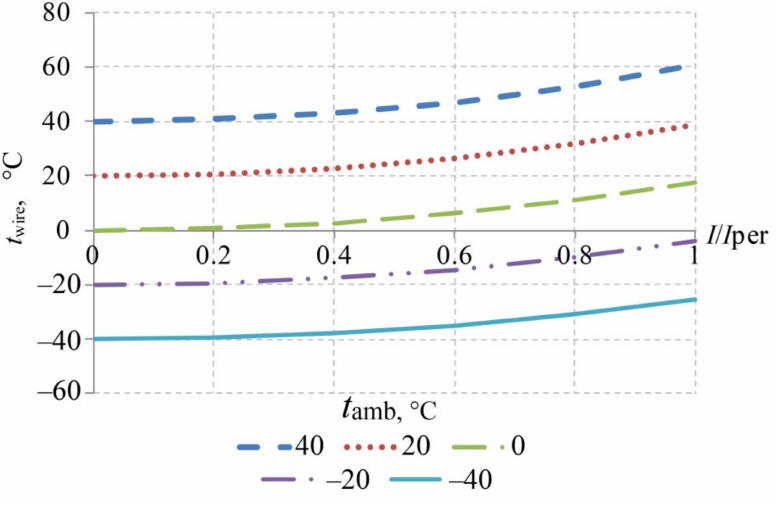
Figure 3. Relationship between the temperature of the AC-120 wire of the overhead power line and the ambient temperature at the average wind speed ( υ = 2 m/s).